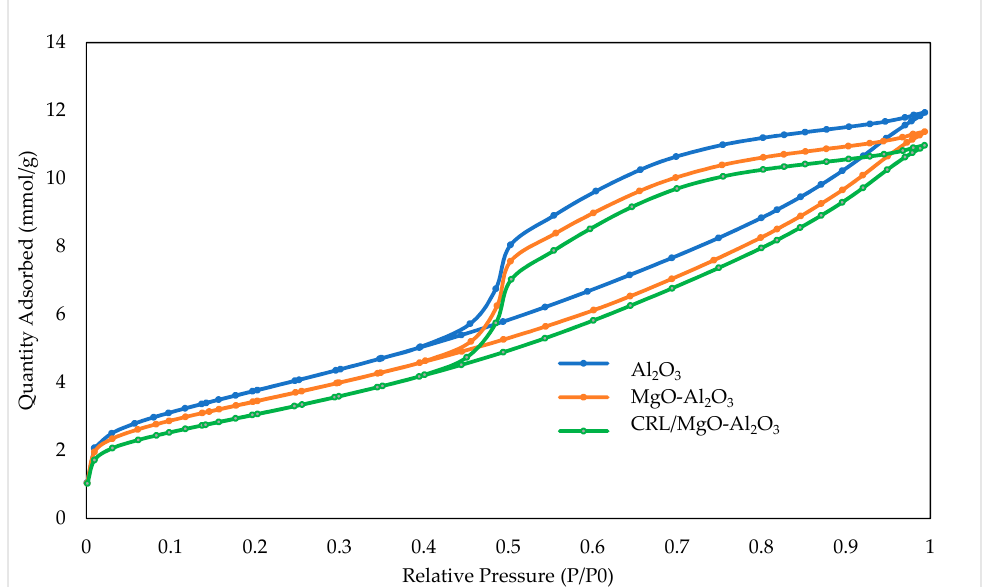
Figure 13. Nitrogen adsorption–desorption isotherms for Al 2 O 3 , MgO- Al 2 O 3 , and CRL/MgO-Al 2 O 3 , respectively.